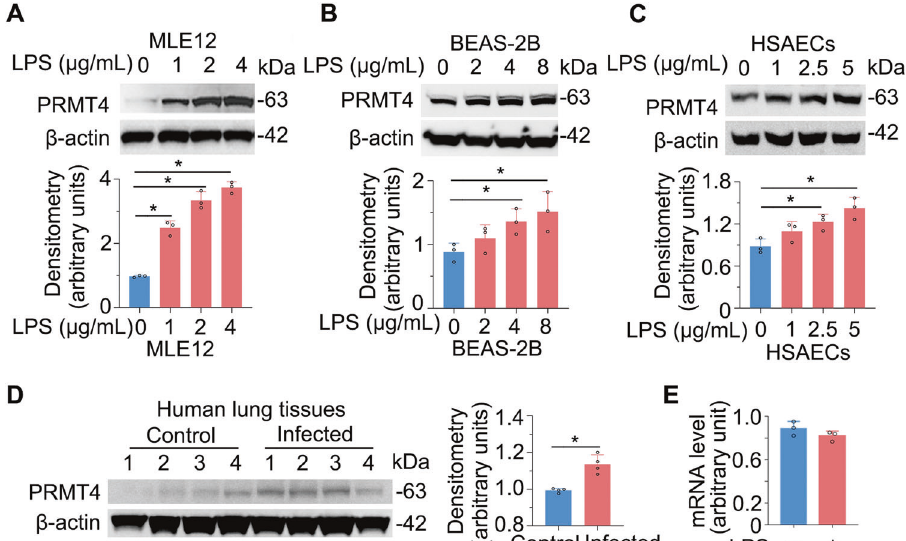
Fig. 1 LPS increases PRMT4 protein in epithelia. A MLE12 cells were treated with LPS as indicated; cell lysates were immunoblotted with PRMT4 and β -actin antibodies. B BEAS-2B cells were treated with LPS as indicated; cell lysates were immunoblotted with PRMT4 and β -actin antibodies. C Primary human small airway epithelial cells (HSAECs) were treated with LPS as indicated; cell lysate was collected and analyzed with PRMT4 and β -actin antibodies. For A – C , relative expression of PRMT4 was plotted in the below panels. D Lung tissue lysates from deidenti fi ed human lung samples from normal and infected patients were analyzed for PRMT4 and β -actin by immunoblotting. Densitometry was presented in the right panel. E PRMT4 mRNA levels were determined by qRT-PCR in LPS-treated bronchial epithelial cells. Experiments n = 3. Statistical signi fi cance was indicated with asterisk “ * ” between groups where P < 0.05 vs. control